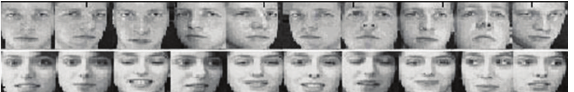
Figure 7: Subset of digit “0” and character “O” in the Binary Alphadigits database.